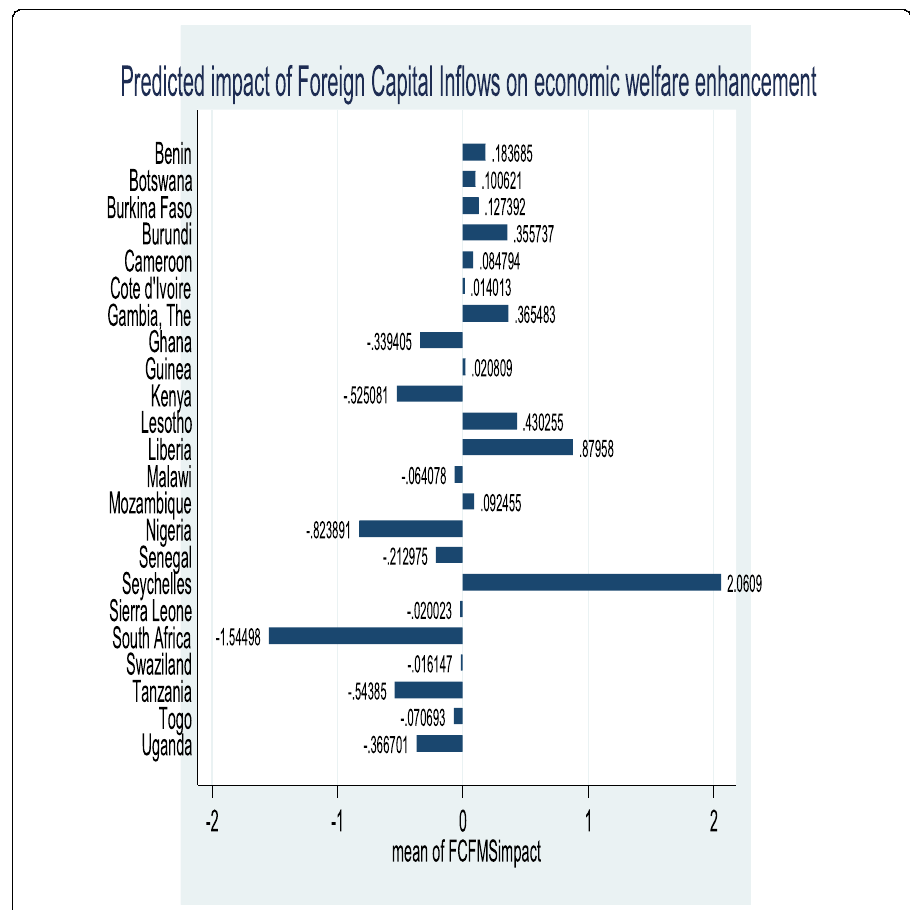
Fig. 4 FCF1: Predicted (mean) impact of FC1 on economic welfare at different levels of financial development (Money supply as proxy for financial